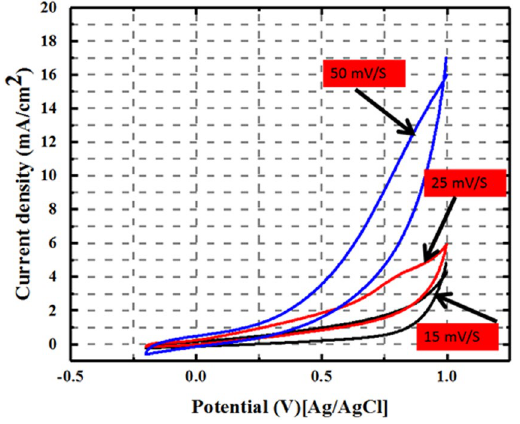
Figure 8. Cyclic voltammograms for the obtained core@shell (ZnO@C) carbon spheres in 1 M KOH soution in the presence of 4 M methanol at various scan